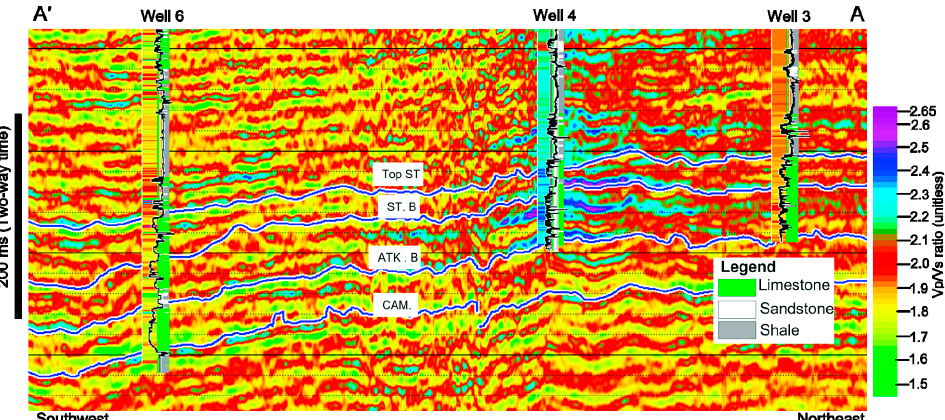
Figure 12. Cross section A–A ′ of inverted Vp/Vs-ratio volumes passing through wells 3, 4, and 6. Note: all inserted logs and abbreviated horizon names as defined in Figure 8.